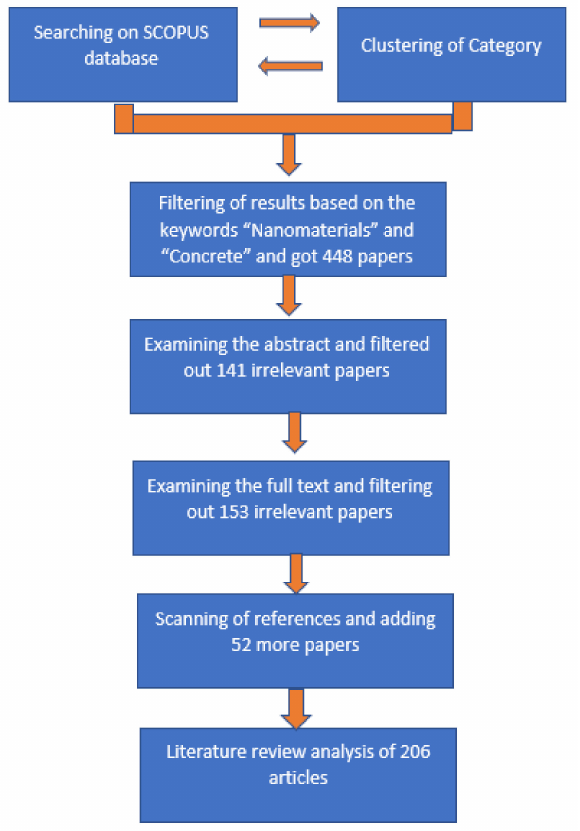
Figure 4. A flow chart demonstrating the steps of the literature review’s